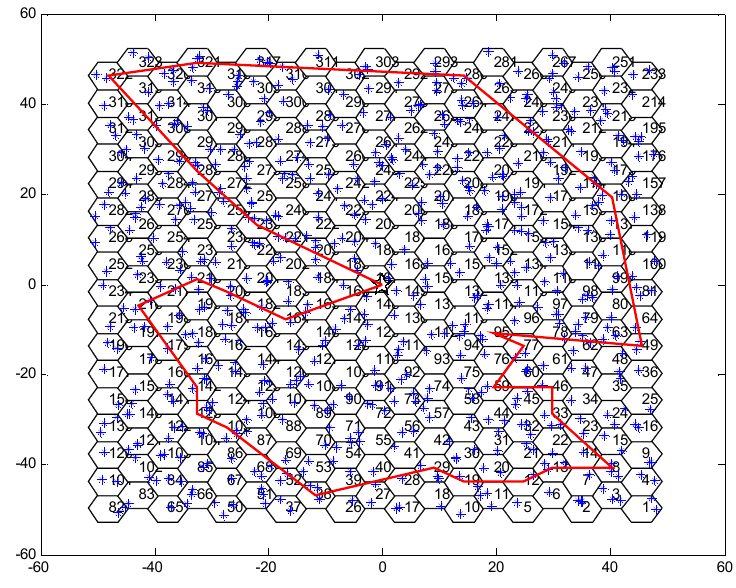
Figure 12. The traveling path of the WCV.